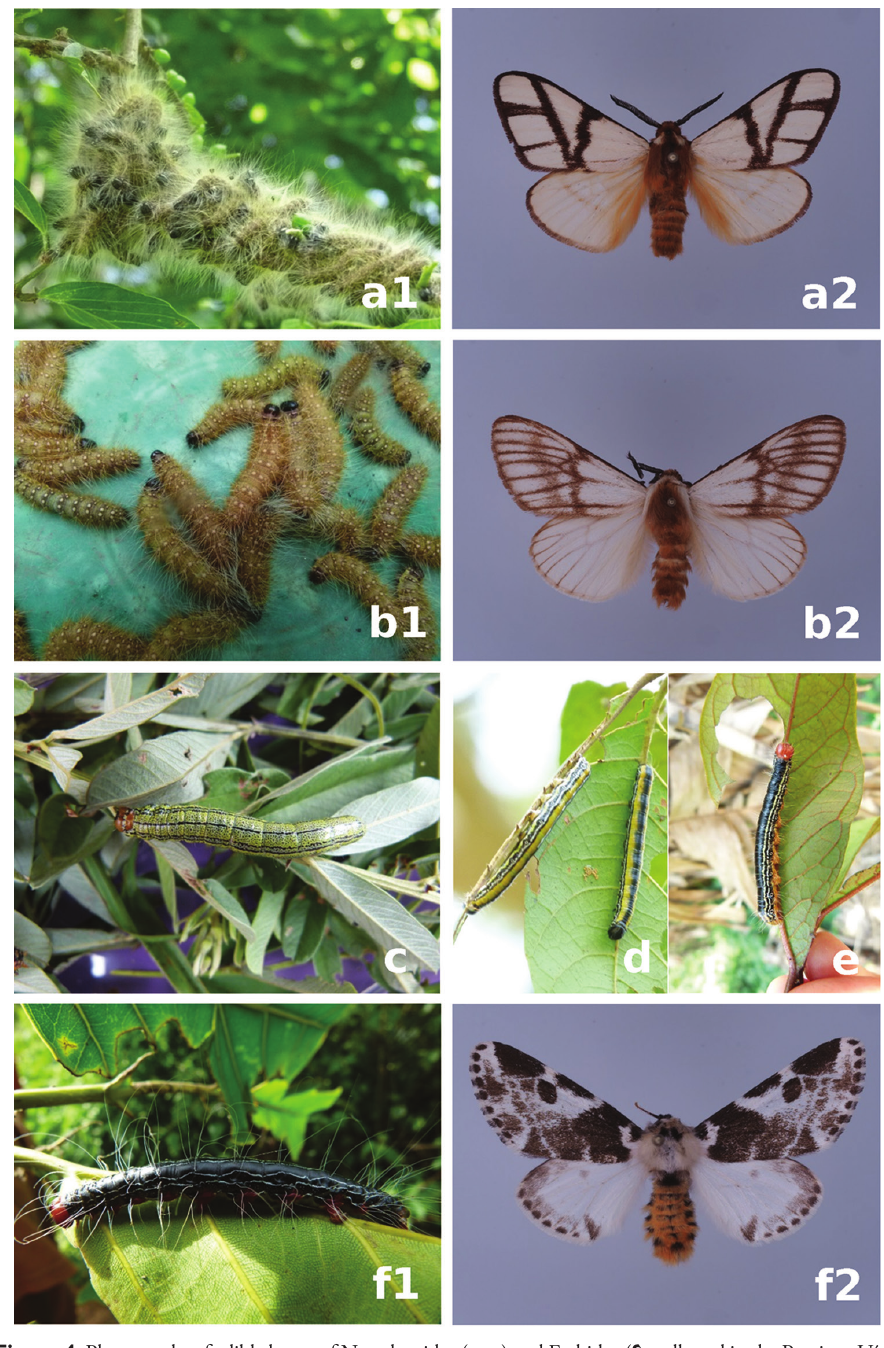
Figure 4. Photographs of edible larvae of Notodontidae ( a–e ) and Erebidae ( f ), collected in the Province Uíge. a Anaphe panda (1) larva (2) male imago b Anaphe venata (1) larva, (2) male imago, c Notodontidae sp. 1 d Notodontidae sp. 2 (left) and e Notodontidae sp. 4 (right) f Sciatta inconcisa (1) larva, (2) male